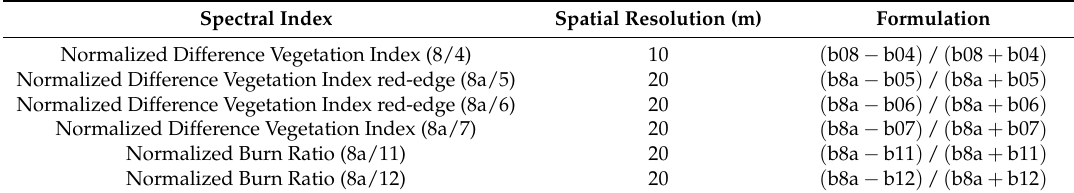
Table 3. Spectral indices (denoted by the two bands used) considered in this study. Spectral Index Spatial Resolution (m)